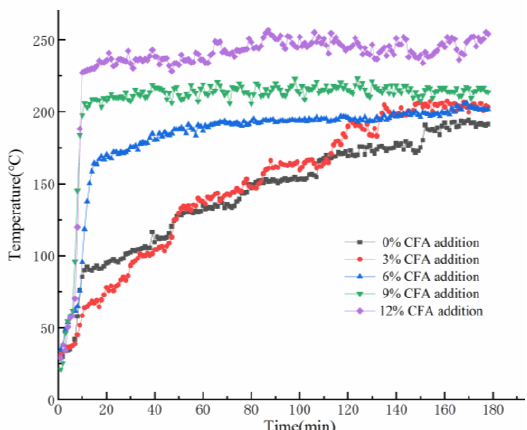
Figure 5. Variation trends of the back-side temperatures of the prepared GFs during the fire-resistance tests.